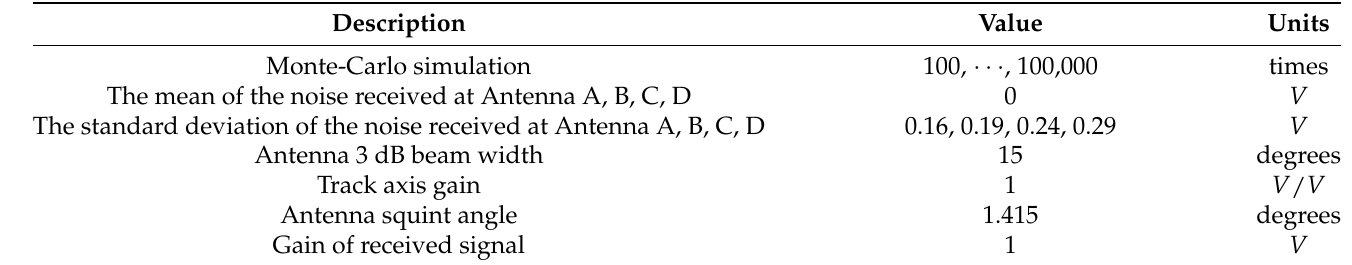
Table 2. Parameters for Test